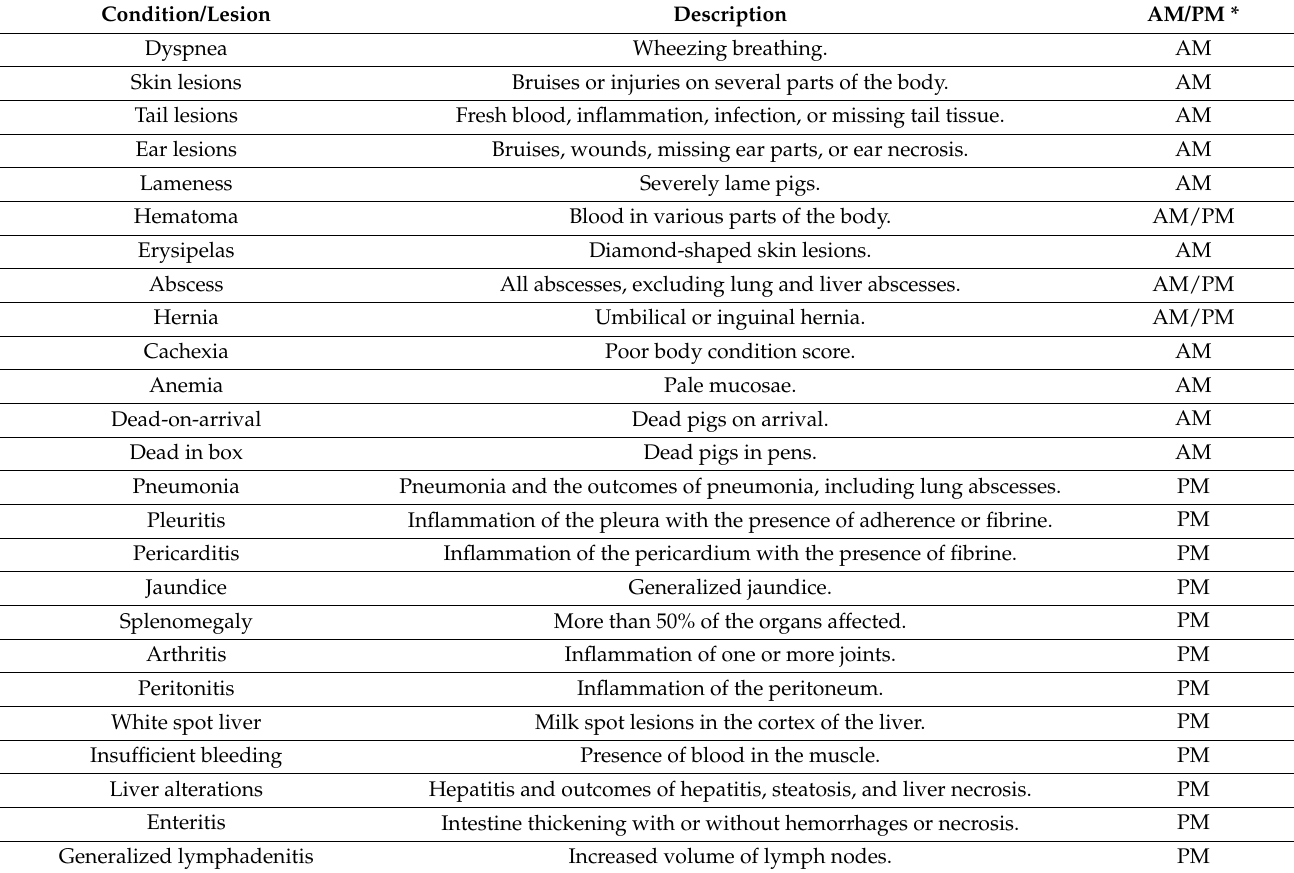
Table 1. Form adopted for ante-mortem (AM) and post-mortem (PM) relief, partially adapted from Ghidini et al.